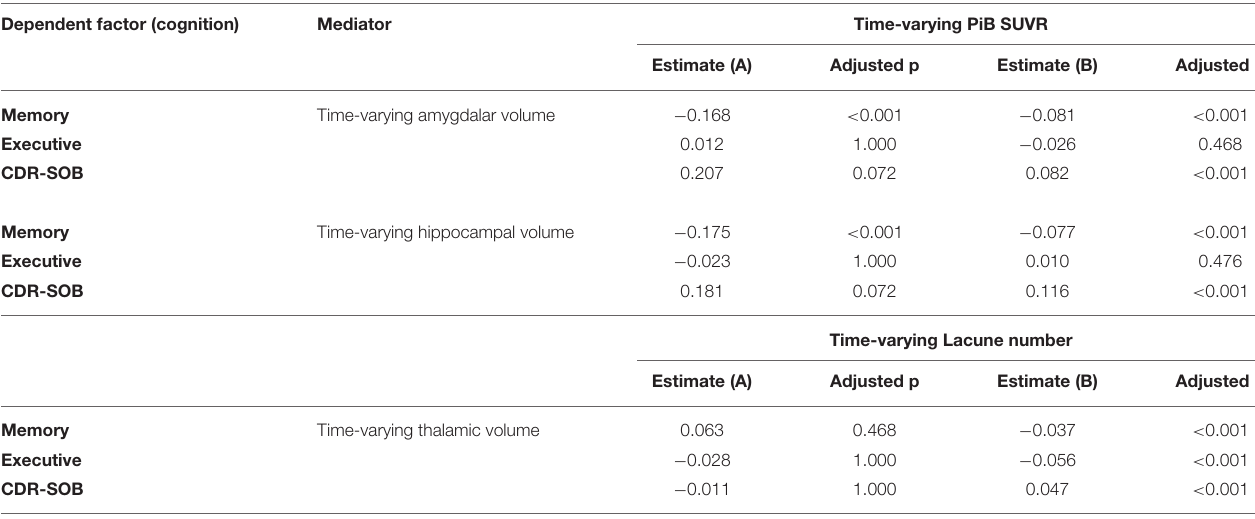
TABLE 2 | Mediation analyses of subcortical structural volume changes in the relationship between Pittsburg compound B (PiB) standard uptake value ratio (SUVR)/lacune changes and cognitive decline. Dependent factor